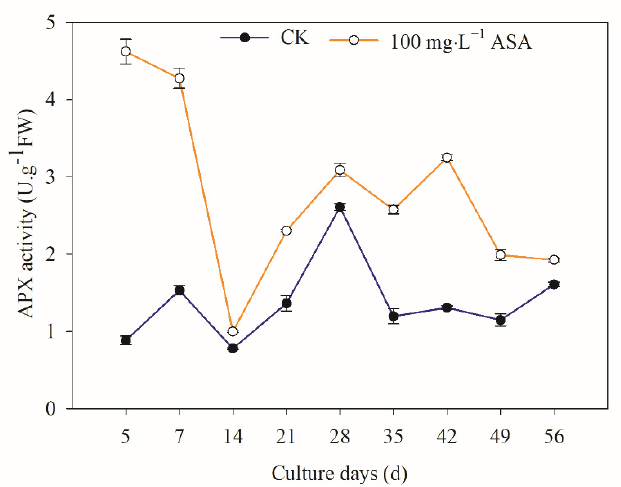
Figure 10. Effects of 0 and 100 mg · L − 1 ASA treatments on APX activity during somatic embryogenesis of Fraxinus mandshurica provenance 3. The x -axis represents the culturing days, and the y -axis represents the APX activity. Error bars show the standard error of the mean.